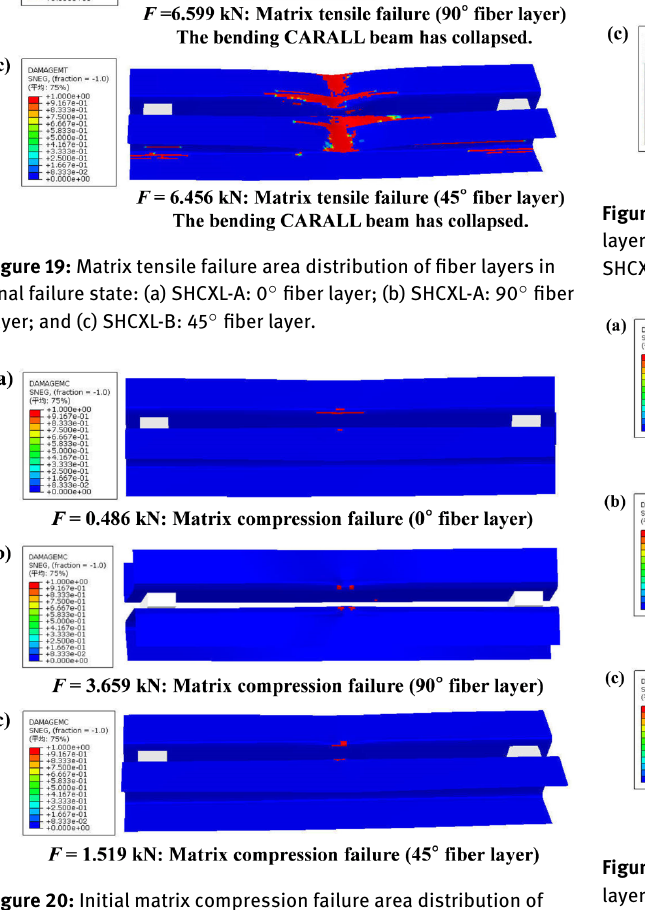
Figure 20: Initial matrix compression failure area distribution of fiber layers: (a) SHCXL-A: 0 ∘ fiber layer; (b) SHCXL-A: 90 ∘ fiber layer; and (c) SHCXL-B: 45 ∘ fiber layer.